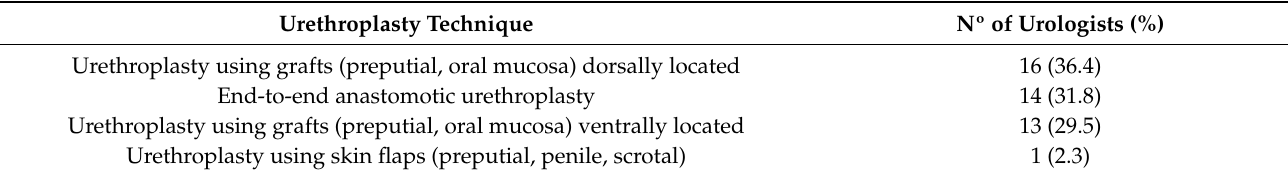
Table 6. Preferred urethroplasty techniques for bulbar strictures.